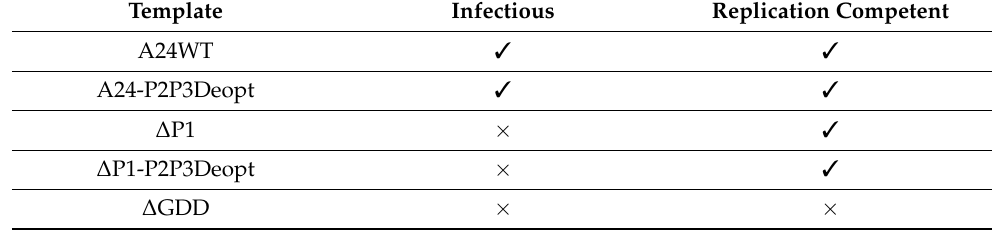
Figure 1. Schematic diagram of the FMDV RNA templates used during transfection. DIVA markers are indicated by open (3B1 deletion, RQKP9-12 → PVKV) and closed (3D H27N31 → YR) triangles. Deoptimized regions are indicated by stripes. Δ GDD within the active site of RdRp encoded by 3D is indicated by an X.